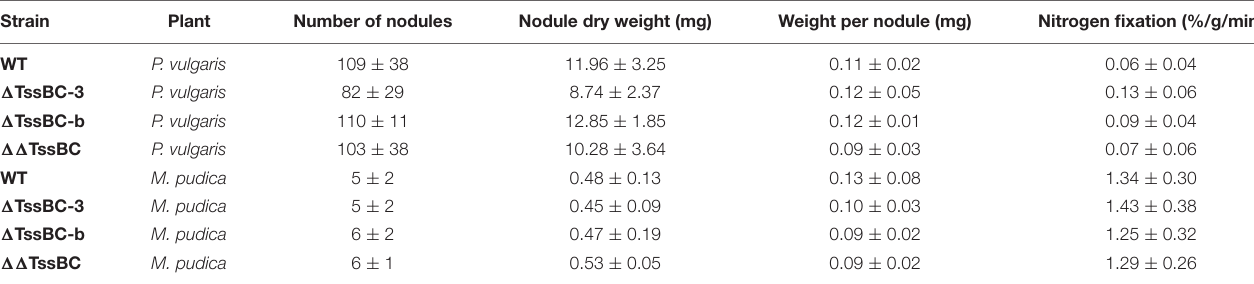
TABLE 1 | The symbiotic properties (nodules per plant, weight per nodule, and nitrogenase activity) of P. vulgaris and M. pudica nodules infected by P. phymatum wild-type, (cid:49) T6SS-b, (cid:49) T6SS-3, and (cid:49)(cid:49) T6SS. Strain Plant Number of nodules Nodule dry weight (mg) Weight per nodule (mg) Nitrogen fixation